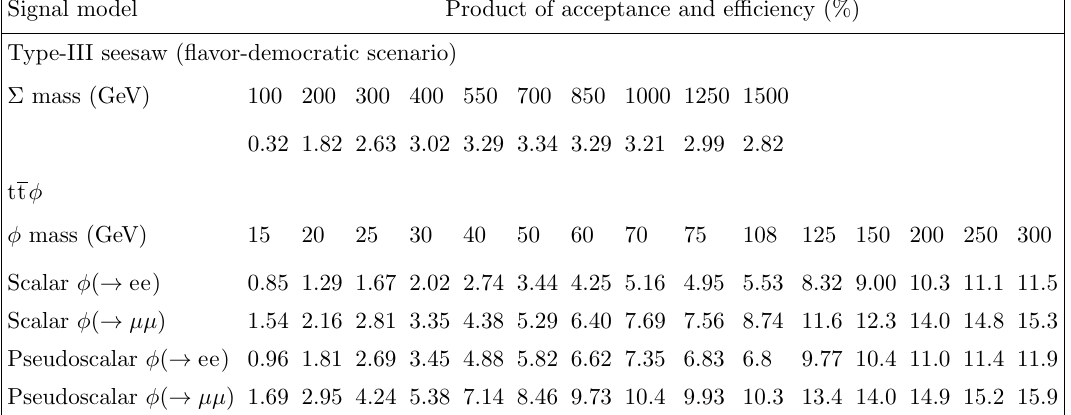
Table 4 . Product of the (cid:12)ducial acceptance and the event selection e(cid:14)ciency for the signal models at various signal mass hypotheses calculated after all analysis selection requirements. quarks, branching fractions of new scalar (pseudoscalar) bosons to dielectrons or dimuons above 0.004 (0.03) are excluded at 95% con(cid:12)dence level for masses in the range 15{75